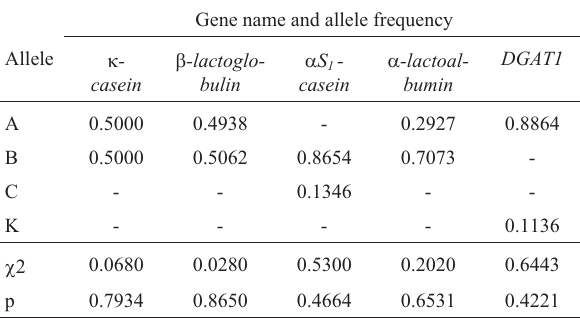
for milk protein genes ( (cid:2) -casein , (cid:3) -lactoglobulin , (cid:4) S 1 -casein , (cid:4) -lacto- albumin ) and the acyl-CoA:diacylglycerol acyltransferase ( DGAT1 )